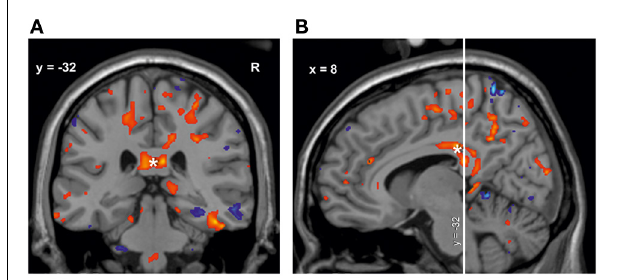
FIGURE 4 | Volume change of M1 musicians compared to controls in the corpus callosum ∗ . (A) Coronal slice ( y = − 32). (B) Sagittal slice ( x = 8). The significant cluster is located in the isthmus and splenium of the corpus callosum, with few voxels reaching the posterior midbody.